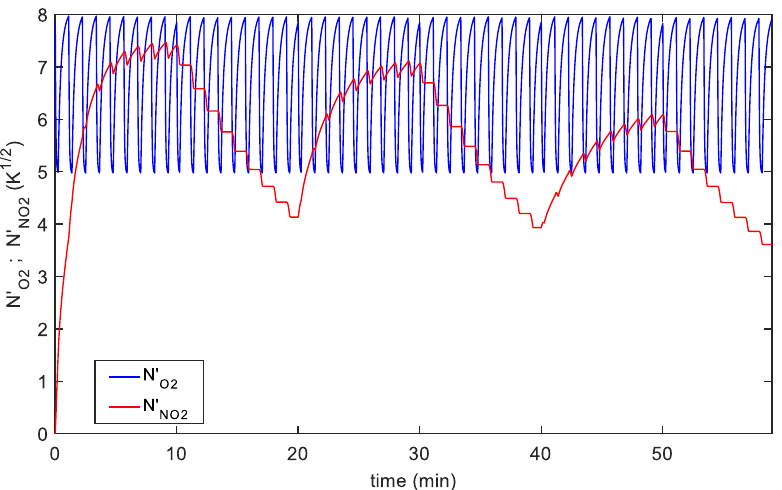
Figure 7. Time behavior of the normalized adsorbed species surface concentration: Red line- 𝑁 𝑁𝑂2′ , blue line- N’ O2 , the plot refers to the fitting results shown in Figure 6b.